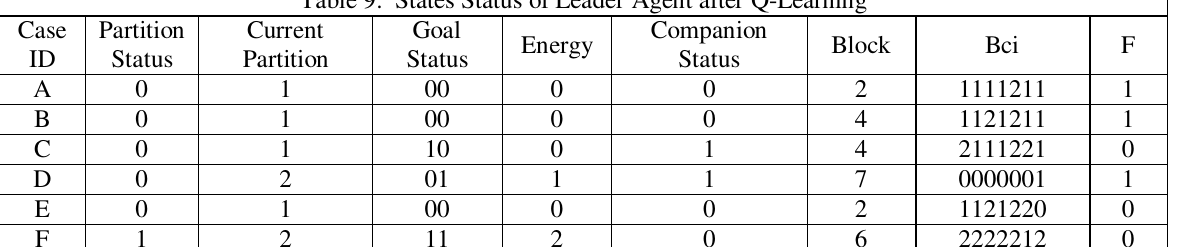
Table 9: States Status of Leader Agent after Q-Learning